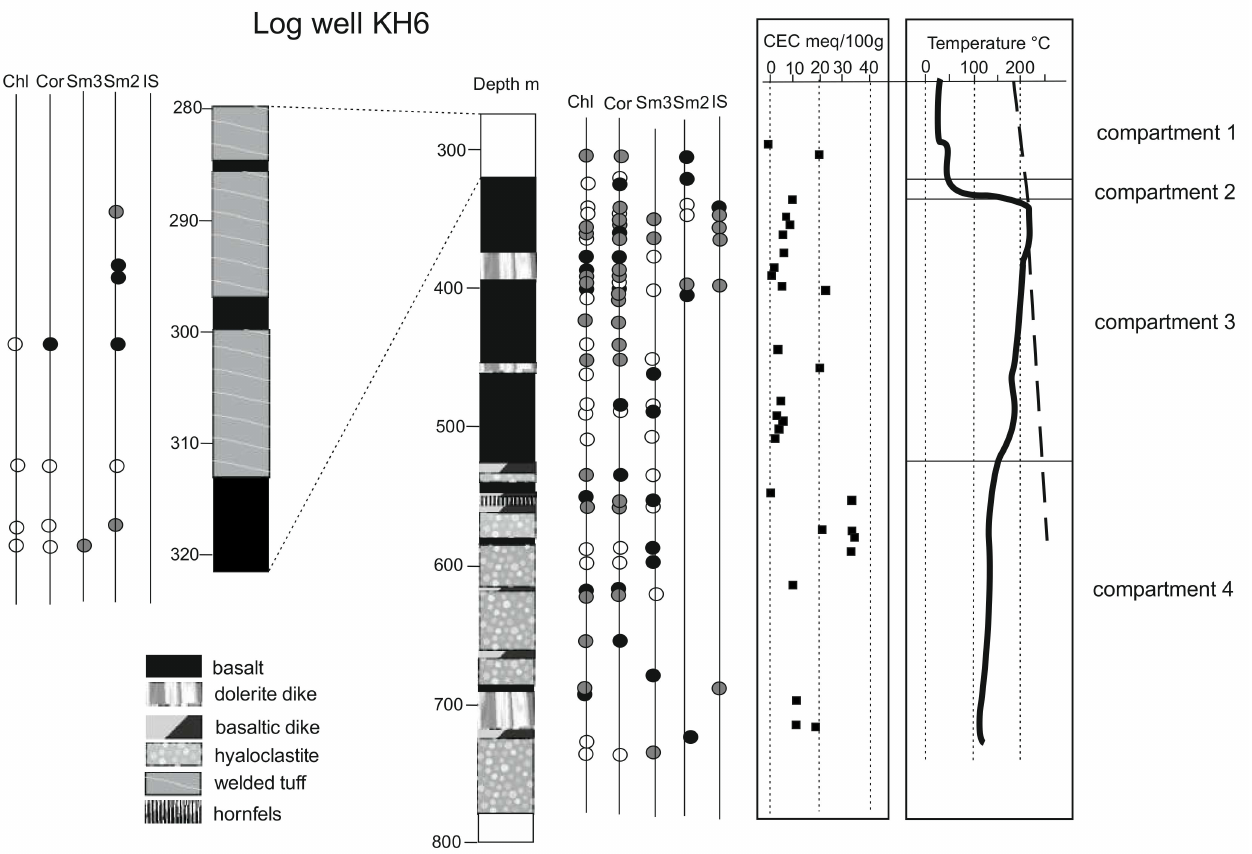
Figure 4. Well KH6-Log shows the in-hole temperature, CEC and secondary minerals present in the analyzed core samples. Chl: chlorite, Cor: corrensite, Sm3: trioctahedral smectite, Sm2: dioctahedral smectite, and I/S: Ill/Sm R1. Black dot: abundant, grey dot: intermediate, white dot: lower amount (qualitative